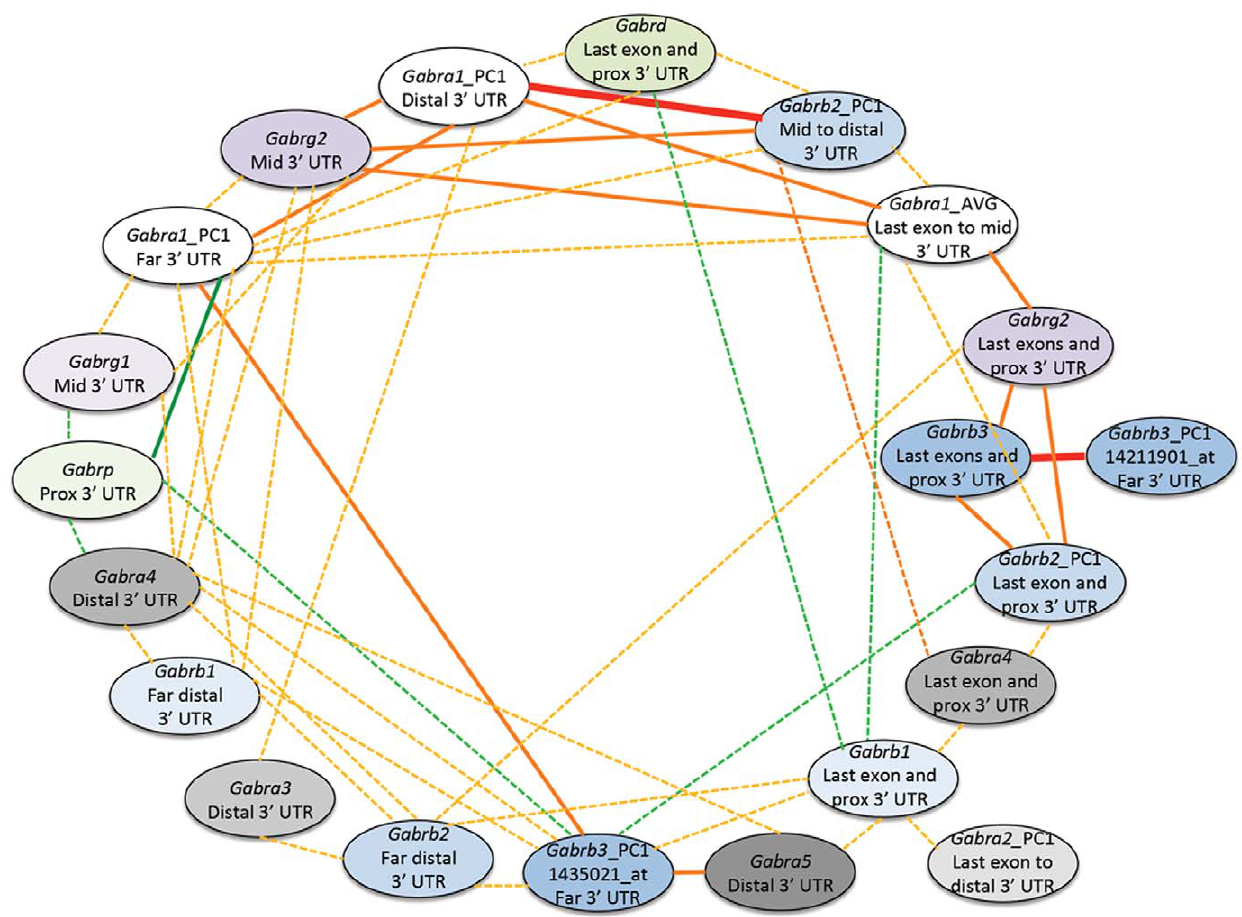
Figure 4. Coexpression of GABA(A) Receptor subunits in the hippocampus. Bold lines indicate a correlation between 1 and 0.7 while normal and dashed lines indicate a correlation between 0.7 and 0.5 and 0.5 and 0.3, respectively. Warm colors represent positive correlations while cool colors represent negative correlations. Probes containing SNPs were removed and a principal component analysis (PCA) was used on the remaining probes to capture the component explaining the majority of the expression variation (PC1) in probe expression among BXD strains. PCA was used to extract PC1 for a single subunit when more than two probe sets were strongly correlated ( r . 0.8) and the average (AVG) was used when two probe sets were strongly correlated. prox=proximal, mid=middle. The highest positive correlations are between subunits targeting the same mRNA region. This is especially true for members of the most common heterotrimeric receptor— Gabra1 , Gabrb2 , and Gabrg2 .